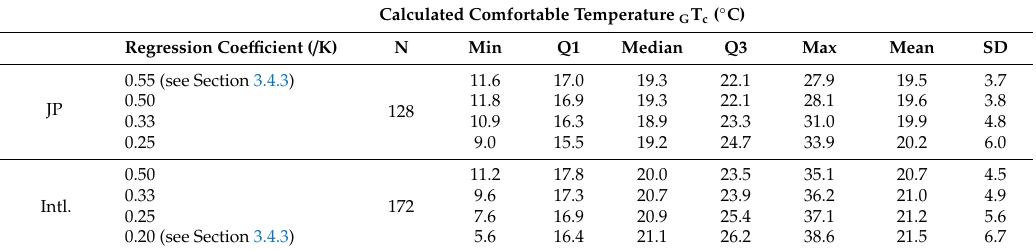
Table 9. Descriptive statistics of comfortable temperature calculated by Gri ffi ths’ method using di ff erent regression coe ffi cients.